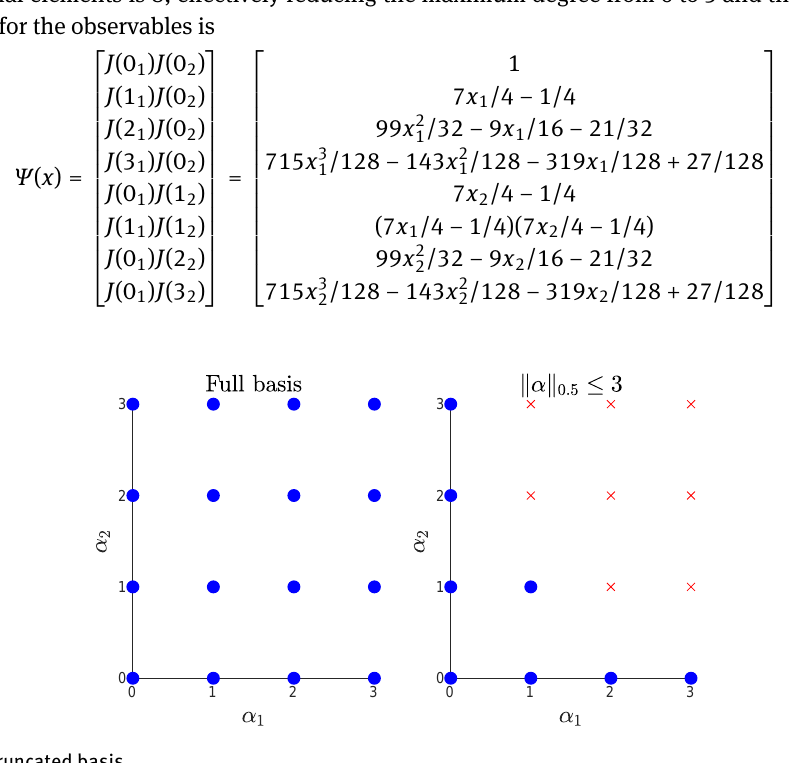
Figure 3: Full basis vs. truncated